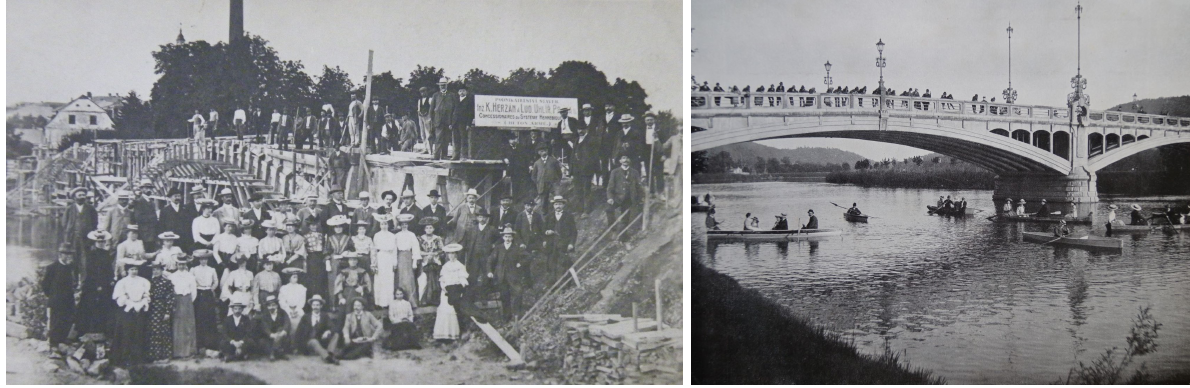
Figure 3. Arch bridge at Hranice, 1905 (left – during construction, right – after completion) [4].